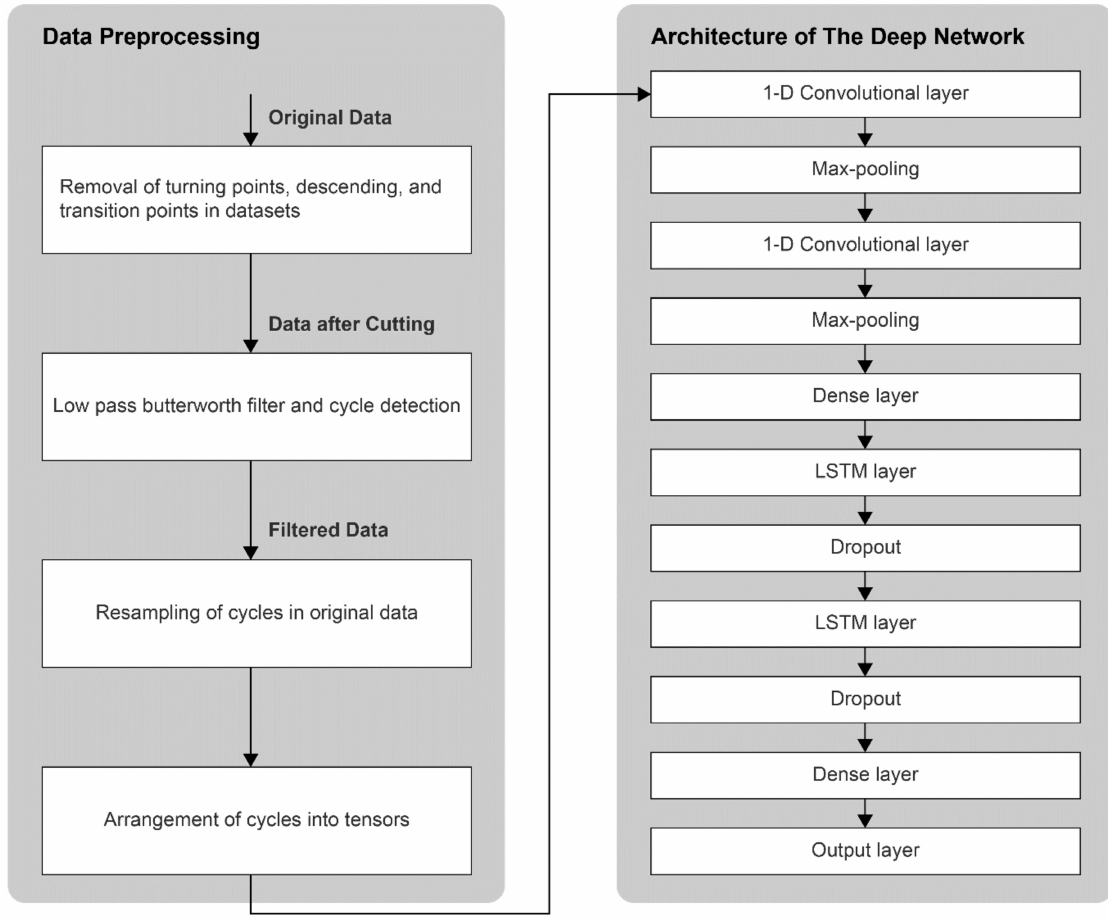
Figure 3. ( Left ) A schematic view of the steps involved in preprocessing of the raw data, and ( Right ) the architecture of the deep neural